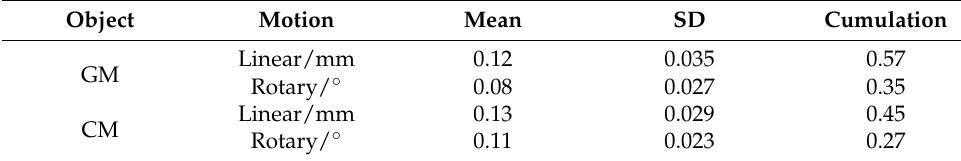
Table 4. Slave robot driving accuracy test